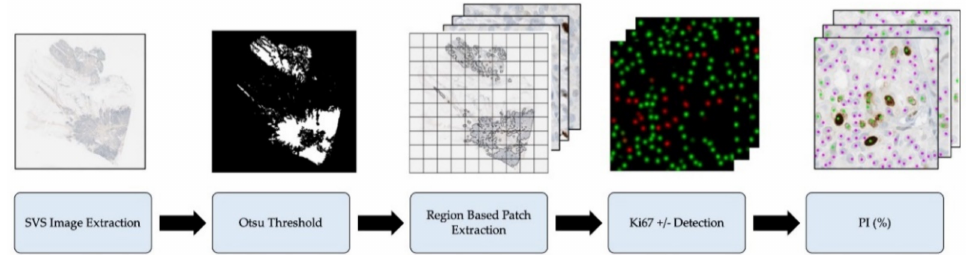
Figure 4. WSI Proliferation preprocessing steps, prior to Ki67+/ − detection and PI